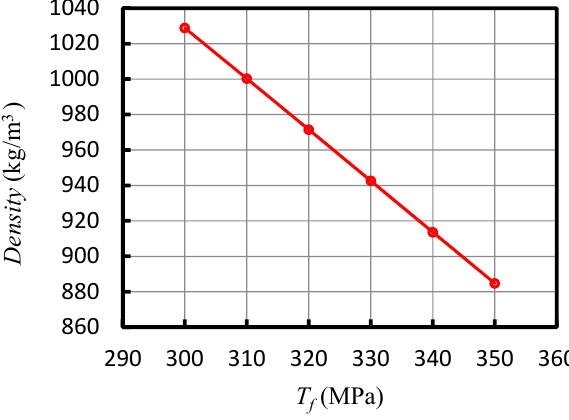
Figure 13. The density of SC-CO 2 fluid versus fluid temperature (Data from REFPROP).